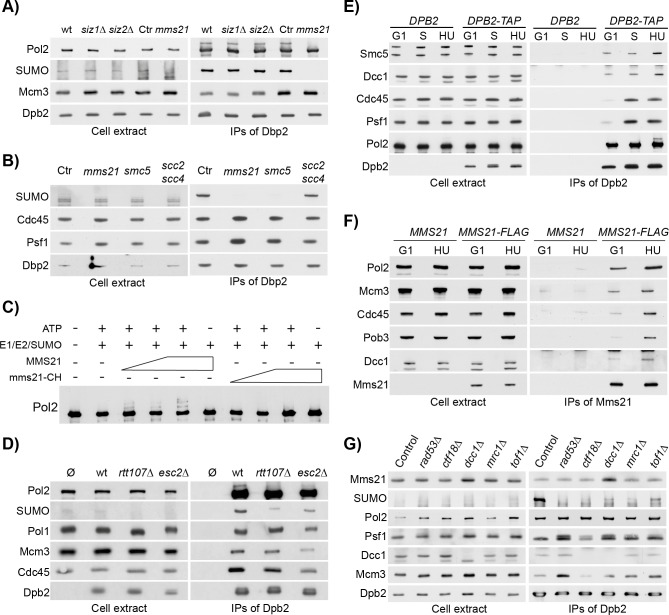
Pol2 is SUMOylated by Mms21 and interacts with the Smc5/6 complex.A) Pol2 SUMOylation depends on the E3-SUMO ligase Mms21. Wild type, siz1Δ and siz2Δ cells were grown to the exponential phase, arrested in G1 and synchronously released in medium containing 0.2 M HU for 90 min. In addition, a control strain (Ctr) and one carrying an auxin-inducible degron allele of MMS21 (mms21), were grown in YPRaf to the exponential phase, arrested in G1, resuspended in YPGal for 35 min, incubated for 60 min in medium containing a final concentration of 0.5 mM indole-3-acetic acid (IAA) to induce protein degradation, and released in YPGal containing 0.2 M HU and 0.5 mM IAA for 90 min. Dpb2-TAP was immunoprecipitated and protein samples were analysed by immunoblotting. B) Smc5/6 complex is required for Pol2 SUMOylation. Strains wild type, mms21-aid (mms21), smc5-aid (smc5), scc2-aid scc4-aid (scc2 scc4) and a control strain were grown in YPRaf to the exponential phase, arrested in G1, resuspended in YPGal for 35 min, incubated for 60 min in medium containing a final concentration of 0.5 mM IAA, and released in YPGal medium containing 0.2 M HU and 0.5 mM IAA for 90 min. Dpb2-TAP was immunoprecipitated and protein samples were analysed by immunoblotting. C) Pol2 is SUMOylated in vitro by Mms21. Pol ε and the Smc5/6 complex—either carrying a wild type allele of MMS21 or the SUMO-ligase defective mms21-(C200A H202A) mutant, (referred to as mms21-CH, also see S4B Fig)—were purified at high salt conditions (700 mM potassium acetate) via a TAP tag (on Dpb2 and Smc5 respectively). SUMO (Smt3GGΔ), the E1 SUMO-activating enzymes Aos1/Uba2 and the E2 SUMO-conjugating enzyme Ubc9 were purified from E. coli. The in vitro SUMOylation reaction was conducted for 60 min at 30°C. D) Pol2 SUMOylation partially depends on RTT107 and ESC2. An untagged strain (Ø), or wild type, rtt107Δ and esc2Δ cells carrying a TAP-tagged allele of DPB2, were grown to the exponential phase, arrested in G1 and synchronously released in medium containing 0.2 M HU for 90 min. Dpb2-TAP was immunoprecipitated and protein samples were analysed by immunoblotting. E) Smc5 co-immunoprecipitates with Pol ε in G1 and S phase. Cells carrying either a tagged or untagged version of Dpb2 were grown to exponential phase, arrested in G1 and released in YPD for 30 min (S) or in YPD 0.2 M HU for 90 min (HU). Dpb2-TAP was immunoprecipitated and protein samples were analysed by immunoblotting. F) Pol2 co-immunoprecipitates with Mms21. Cells carrying a tagged or untagged version of Mms21 were arrested in G1 and released in YPD 0.2 M HU for 90 min (HU). Mms21-5FLAG was immunoprecipitated and protein samples were analysed by immunoblotting. G) Mms21 interaction with Pol ε does not depend on S phase checkpoint components. Wild type cells and sml1Δ rad53Δ, mrc1Δ, tof1Δ, ctf18Δ and dcc1Δ mutants, carrying a tagged version of Dpb2, were arrested in G1 and synchronously released either in YPD for 30 min (S) or in medium containing 0.2 M HU for 90 min (HU). Dpb2-TAP was immunoprecipitated and protein samples were analysed by immunoblotting.